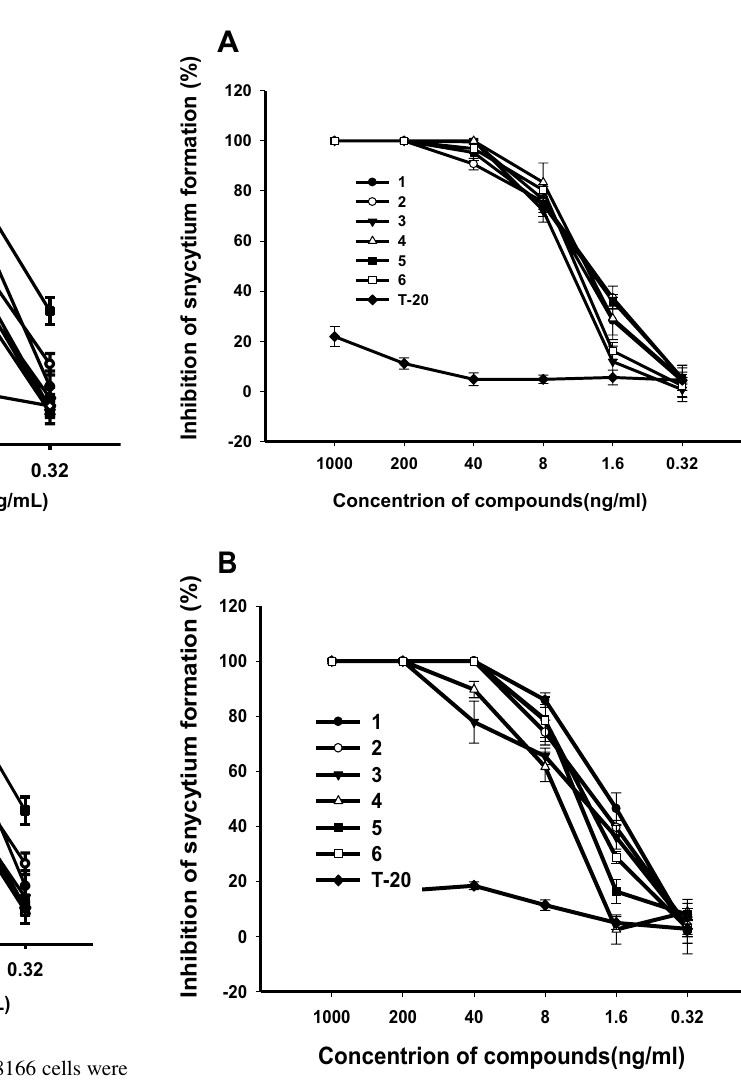
Fig. 4 a The antiviral effects of 1 – 6 on HIV-1 IIIB in C8166 cells were assessed by syncytium formation; inhibitory activities of FuCS-1 on blocking fusion. b Inhibitory effect on cell-to-cell fusion between Fig. 5 a The antiviral effects of 1 – 6 on pNL4-3gp41(36G) normal C8166 cells and HIV-1 IIIB infected H9 cells were measured by V38E,N42S in C8166 cells were assessed by syncytium counting the syncytia formation. Data are expressed as means ± SD